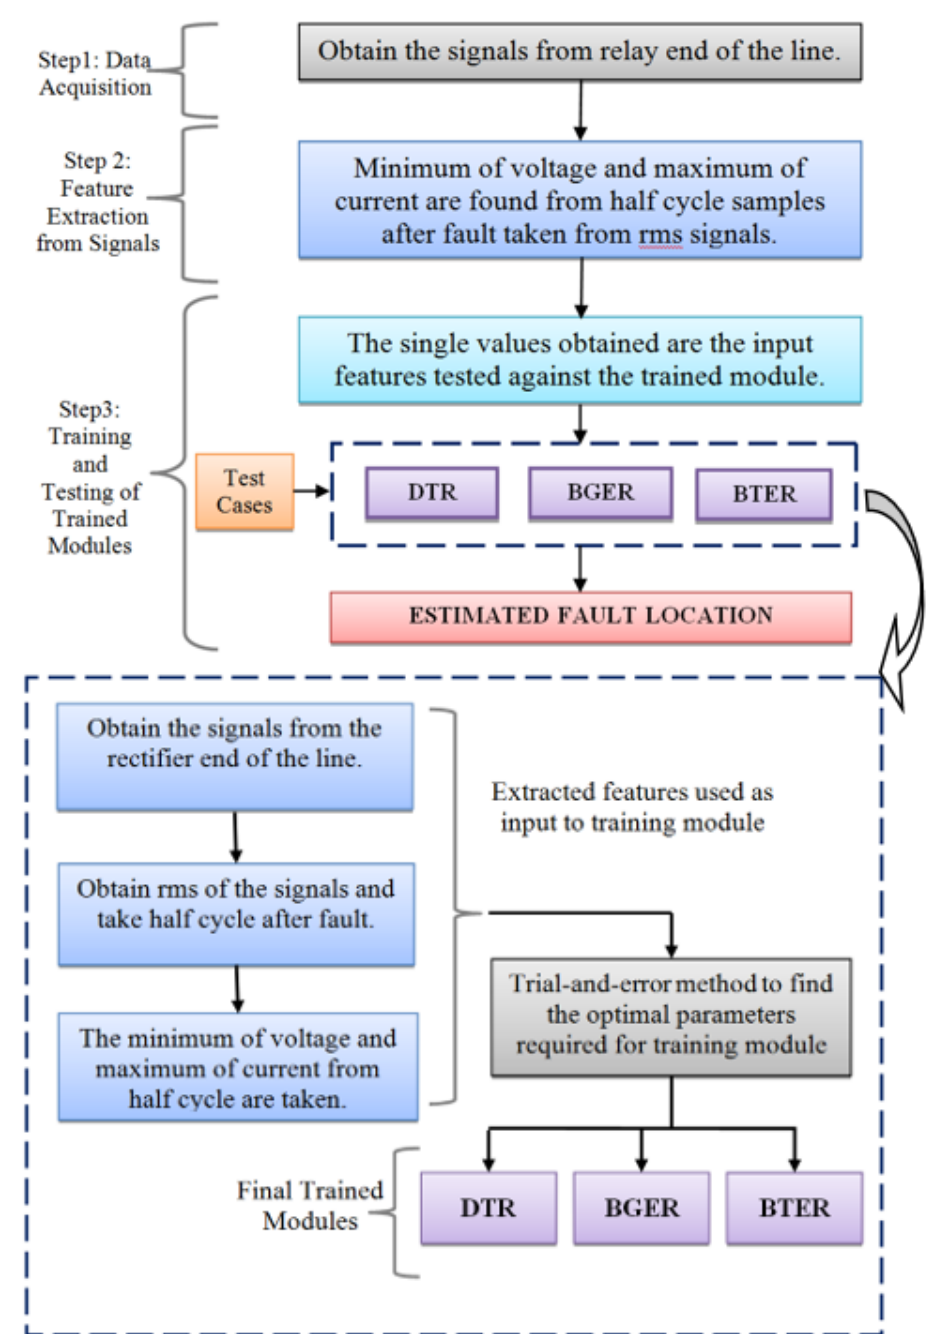
Figure 1. Flowchart of the method.